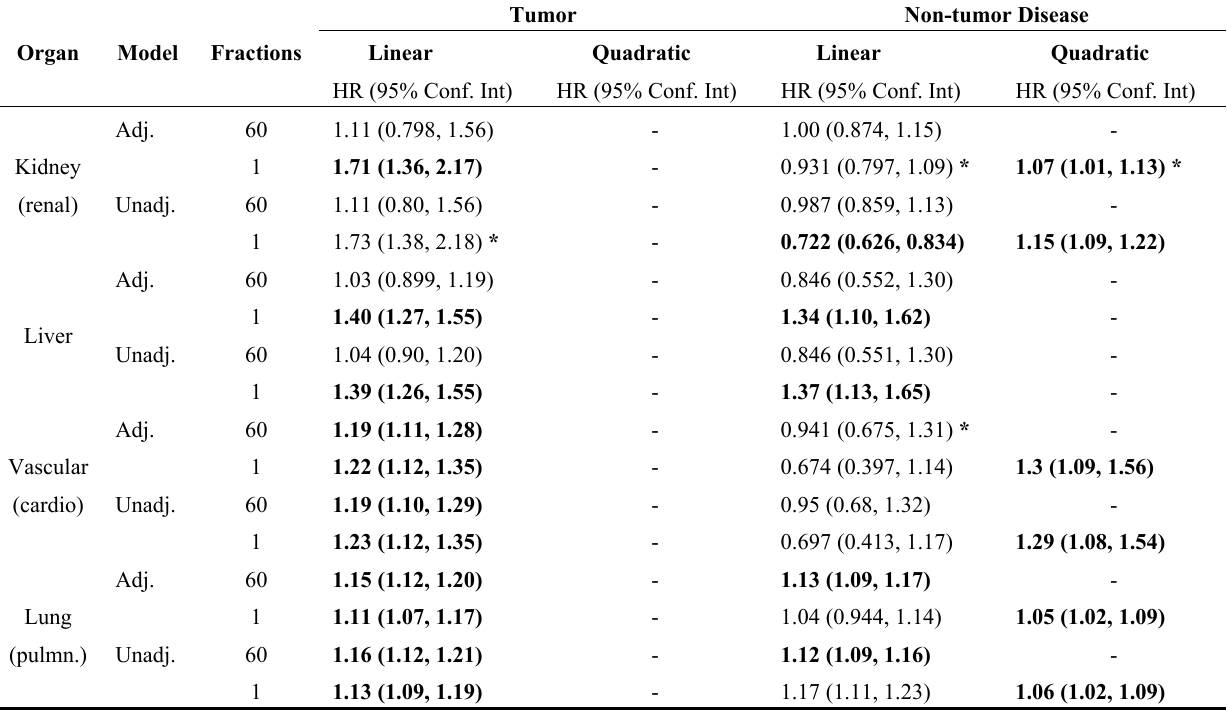
Table of Cox regression hazard ratios (corresponding to the gamma radiation dose term) and accompanying 95% confidence intervals in gamma radiation models. Values in bold indicate significant hazard ratios at the 5% level. Models with non-significant quadratic terms were fit using only the linear term, and those estimates are presented here. Quadratic HR estimates are presented only for models in which there was a significant quadratic term. * indicates that the particular model did not satisfy the proportional hazards